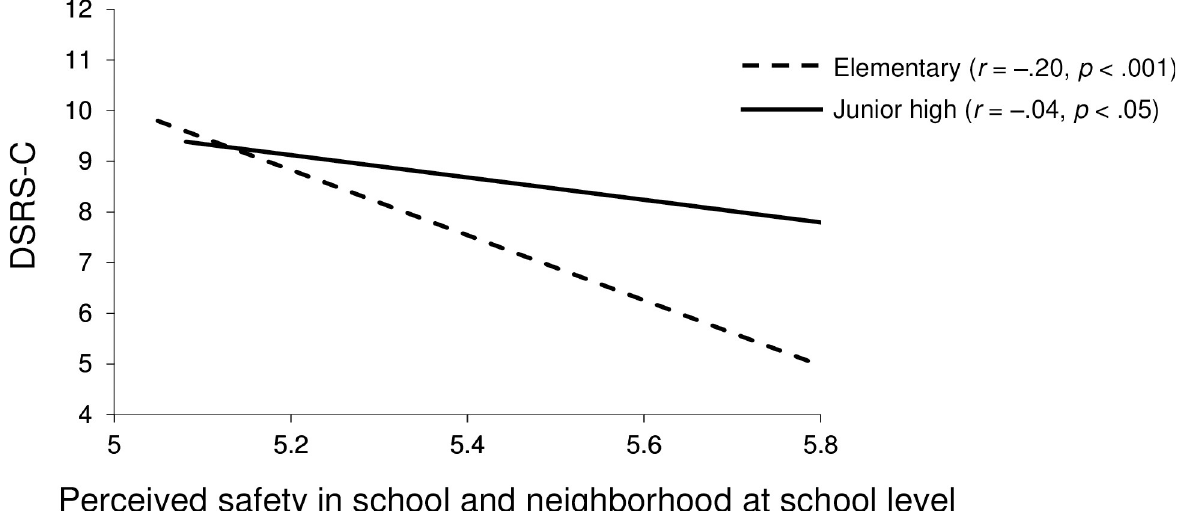
Fig 2. Cross-level interaction between safety and the educational stage on depression. Plots of the impacts of the cross-level interaction between “perceived safety in school and neighborhood” at school-level and educational stage on depression. DSRS-C, Depression Self-Rating Scale for